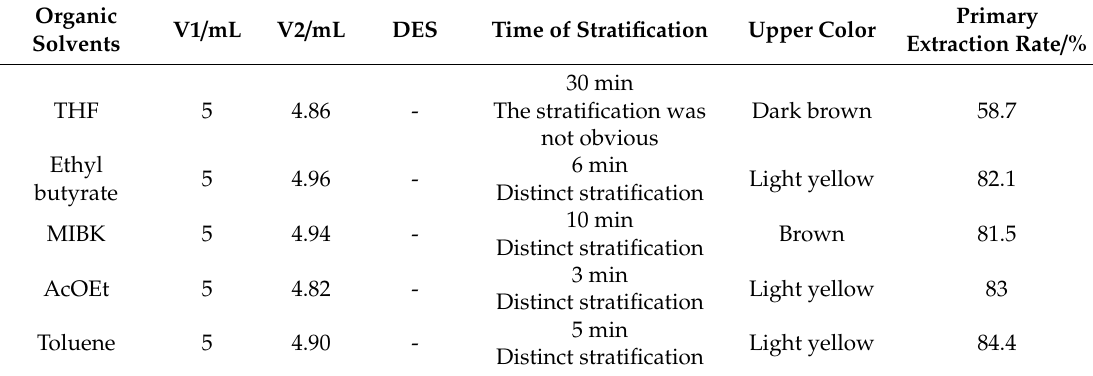
Table 1. The solubility of DES and organic